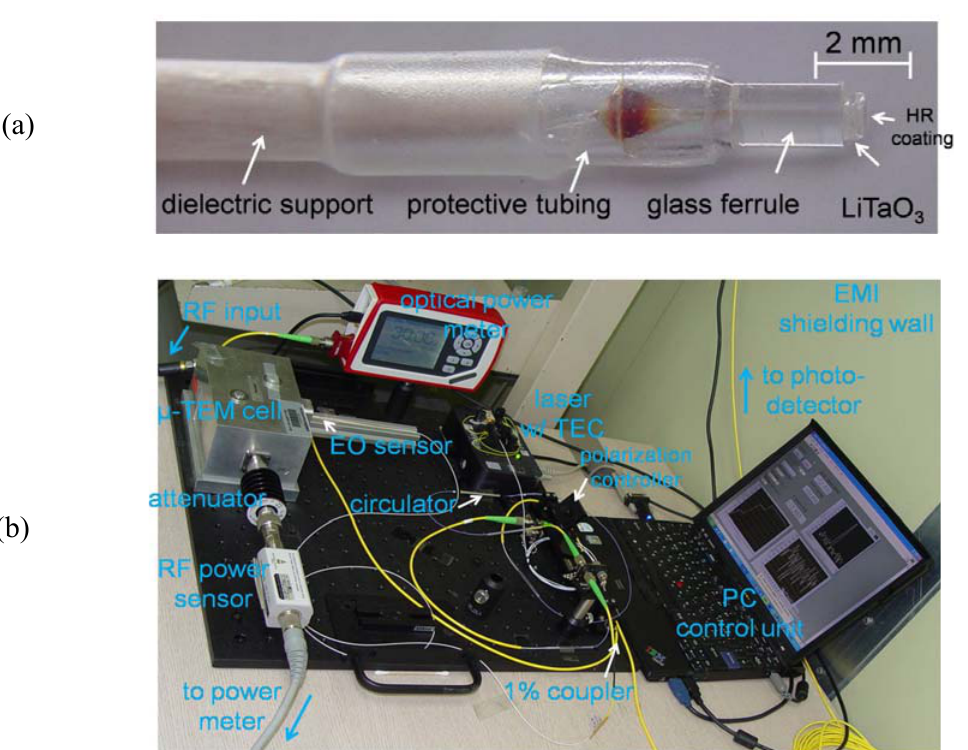
Figure 14. (a) Fabricated probe structure (type III); (b) actual experimental layout depicted in Figure